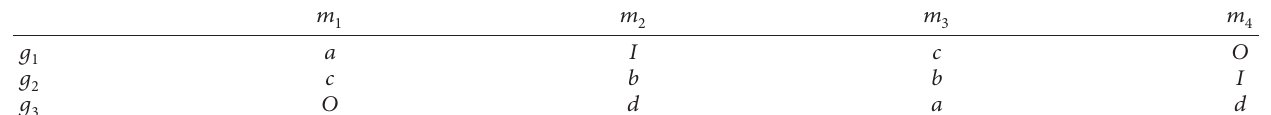
of a hospital department. 3 × 4